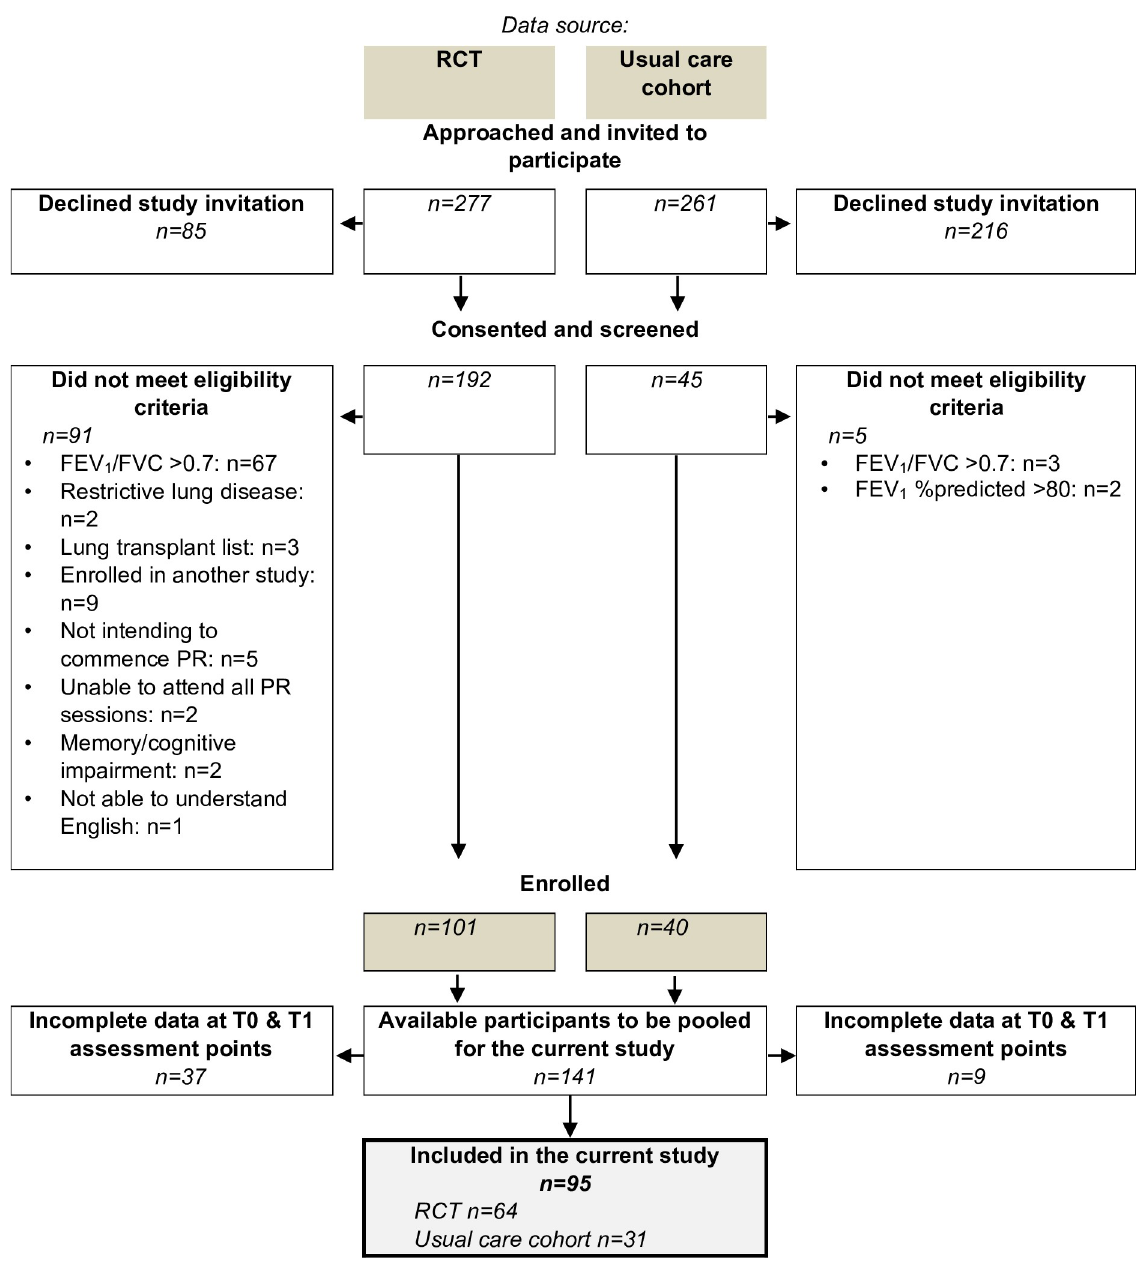
Fig 1. Participant flow. FEV 1 , forced expiratory volume in one second; FVC, forced vital capacity; RCT, randomised control